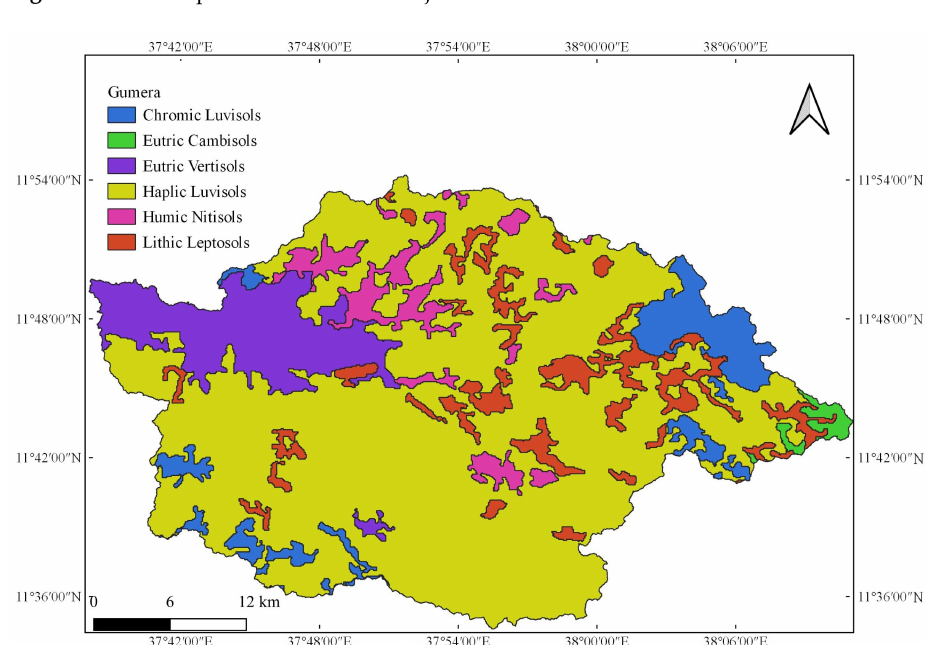
Figure A2. Soil map of Gumera